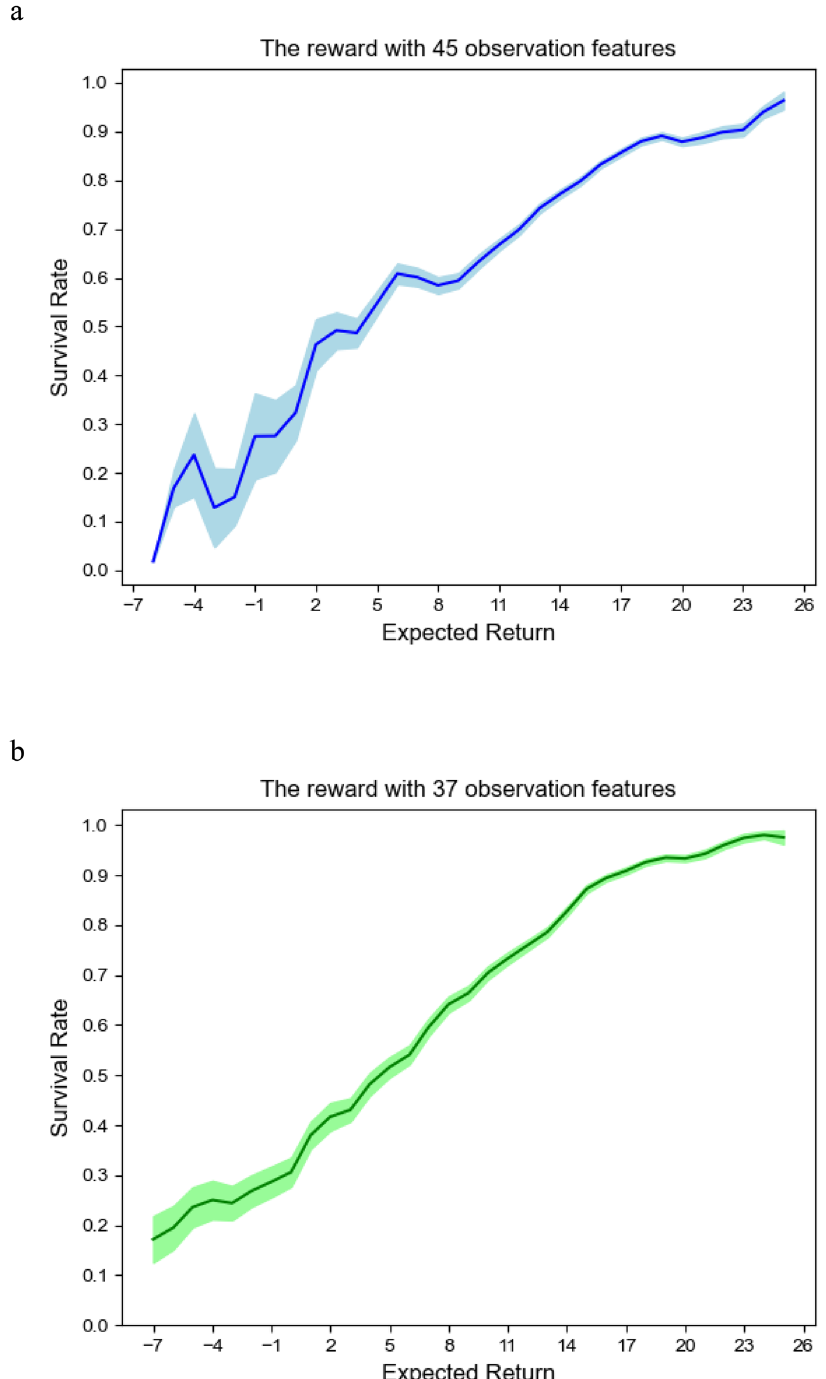
Fig. 7 The relationship between expected return and survival rate. a The relationship between expected return and survival rate for 45 observation features. b The relationship between expected return and survival rate for 37 observation features. The relationship learned from observational data and actions taken by actual clinicians in the MIMIC-III